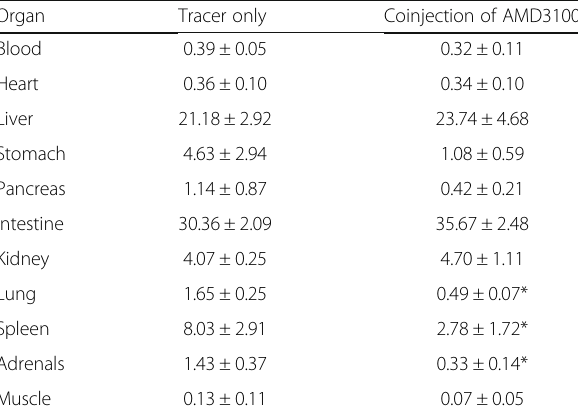
Table 3 Biodistribution of [ 125 I]CPCR4.3 in Black Six normal mice at 60 min p.i. (groups of n = 4). To determine CXCR4 specificity of tracer uptake, 50 μ g AMD3100 (2 mg/kg) were coinjected. Data are cited as %iD/g and are means ±